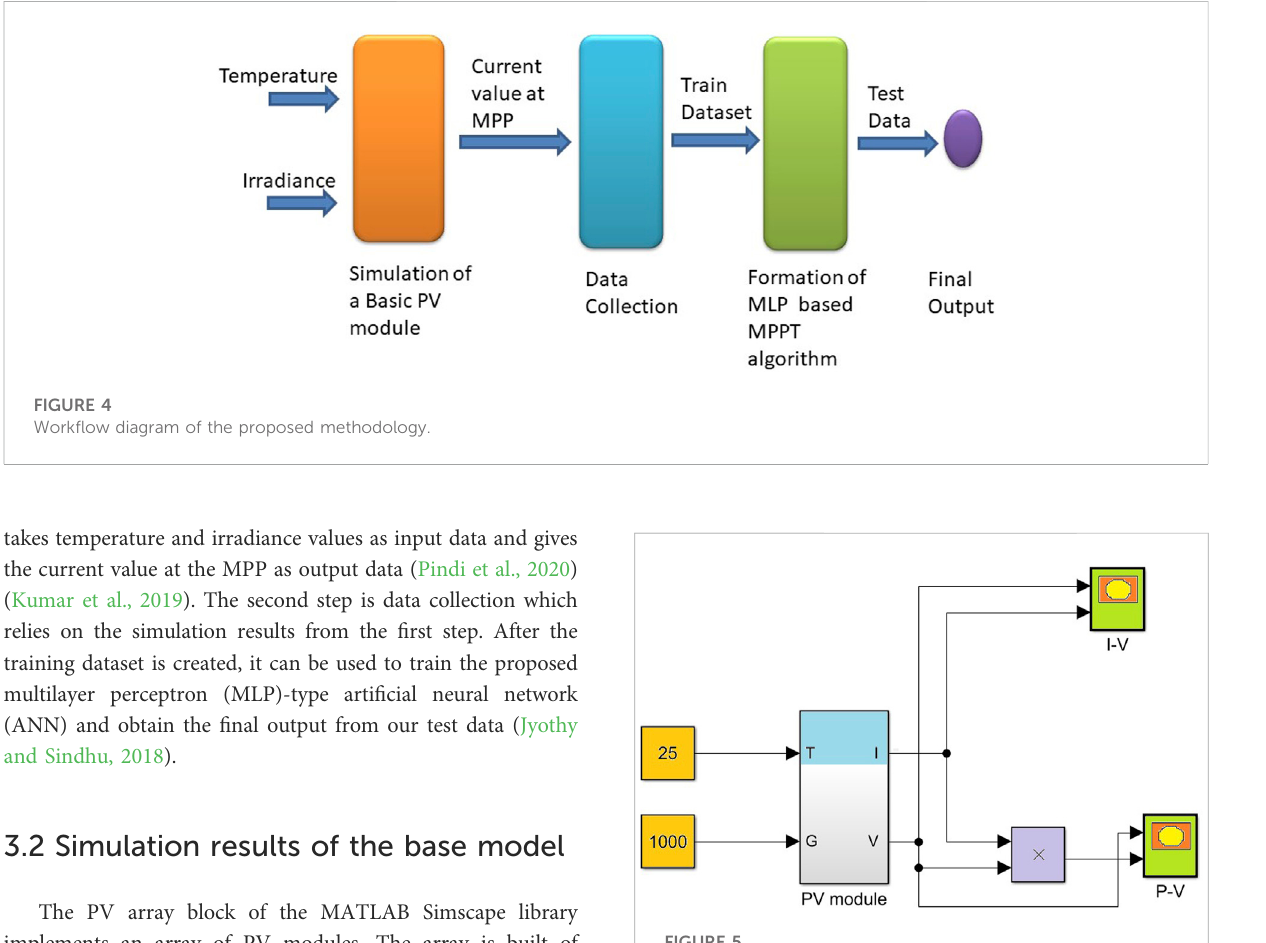
FIGURE 5 Schematic diagram of the output. Let I r = 1000 W/m 2 and T = 25 ⁰